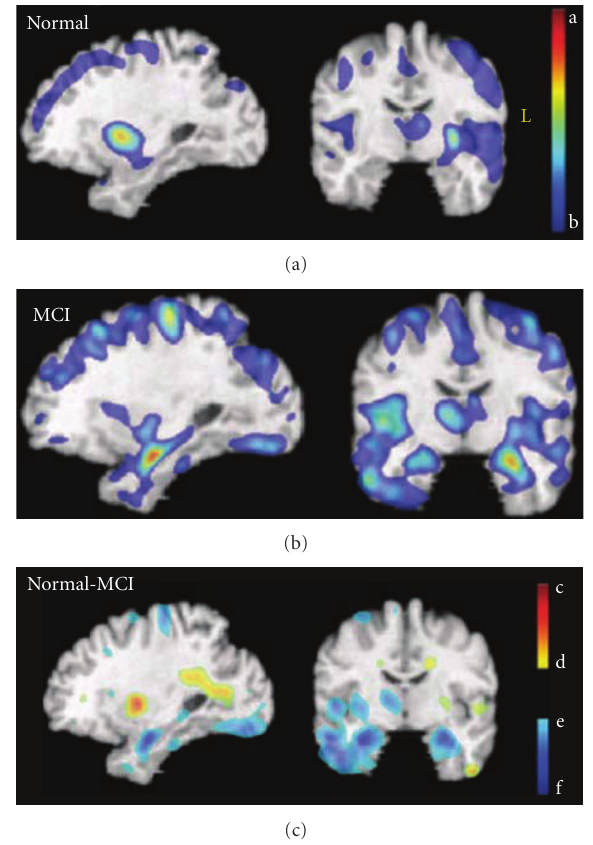
Figure 8: Patterns of GMV loss in MCI and normal aging. Average slopes of RAVENS maps for normal (a) and MCI (b) groups. The red-yellow color indicates greater volume loss. Bottom row: di ff erence between the two groups; blue/green are regions in which MCI subjects showed higher rate of gray matter decrease. (c) Red/yellow colors reflect an increase of periventricular small vessel disease, which appears gray in T1-weighted images and is segmented as gray matter. The color bars display estimated regression coe ffi cients and are defined by the following numbers, all inmm 3 /year (per voxel in the template space): a = − 0 . 020, b = − 0 . 0053, c = 0 . 026, d = 0 . 0053, e = − 0 . 0053, and f = − 0 . 023 (adapted with permission from